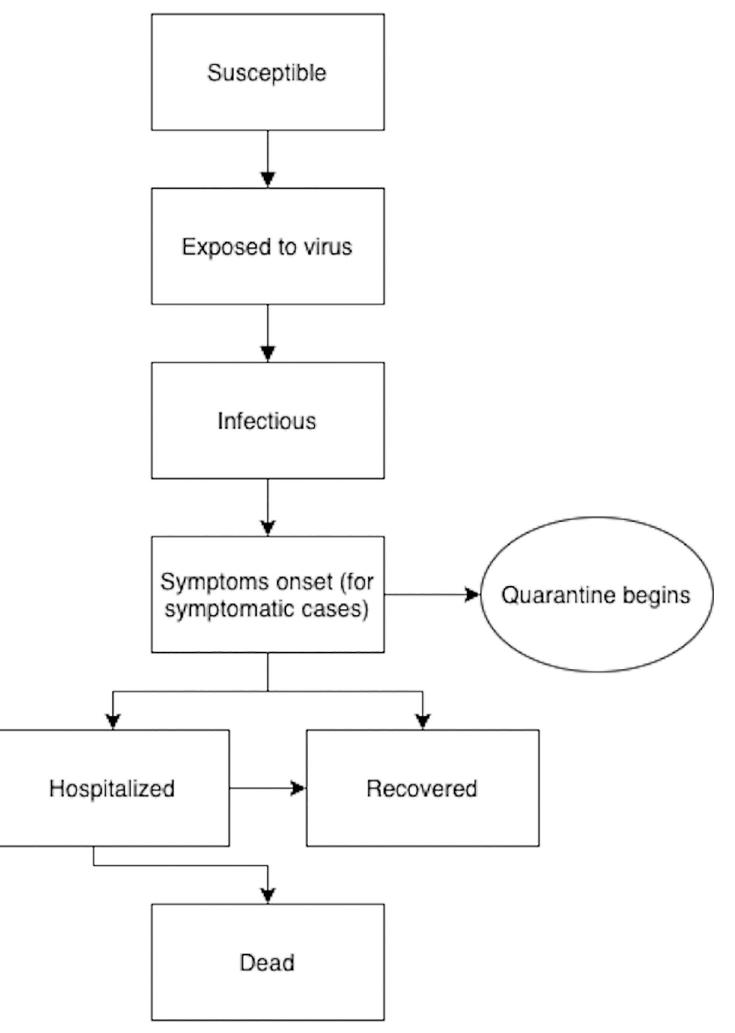
Fig 1. Graphical representation of the states of disease